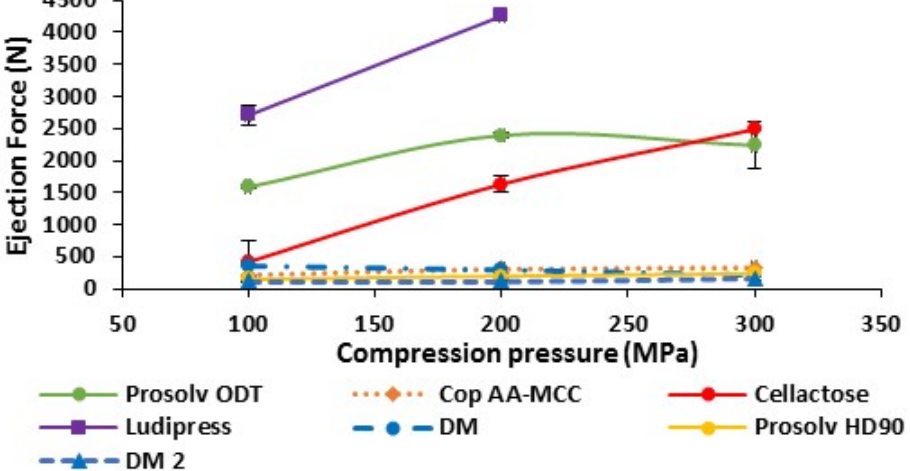
Figure 3. Tablet’s ejection force at different compaction pressures of non-lubricated materials.